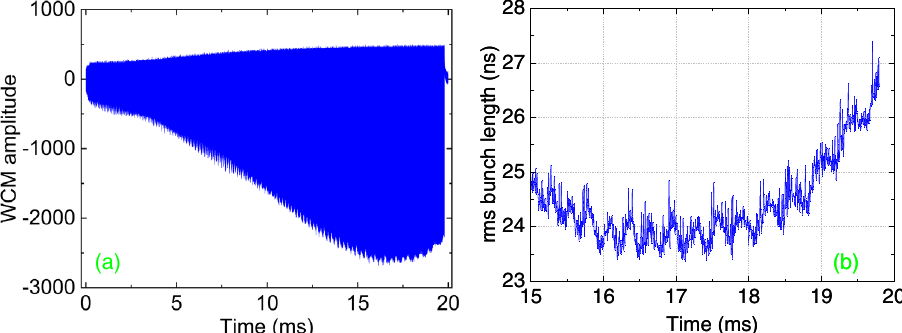
FIG. 2. (a) The beam signal during the whole acceleration cycle measured by the WCM. (b) The rms bunch length from 15 to 19.8 ms or the extraction moment with the corresponding bunch signal fit by a Gaussian function.